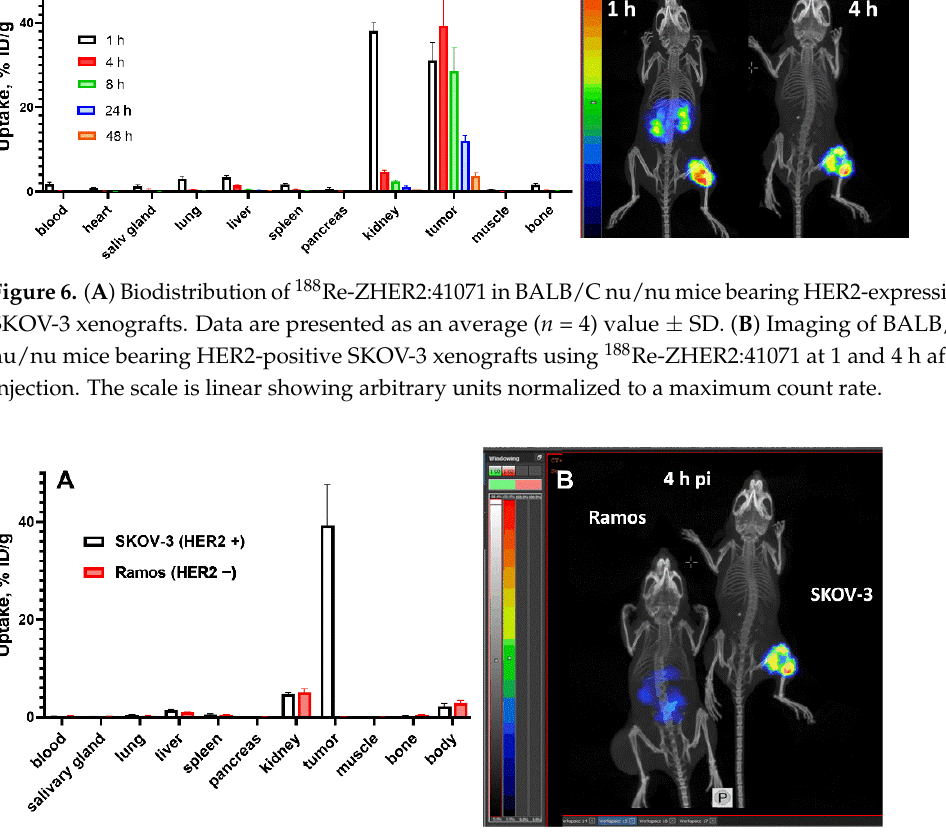
Figure 6. ( A ) Biodistribution of 188 Re-ZHER2:41071 in BALB/C nu/nu mice bearing HER2-expressing SKOV-3 xenografts. Data are presented as an average ( n = 4) value ± SD. ( B ) Imaging of BALB/C nu/nu mice bearing HER2-positive SKOV-3 xenografts using 188 Re-ZHER2:41071 at 1 and 4 h after injection. The scale is linear showing arbitrary units normalized to a maximum count rate.